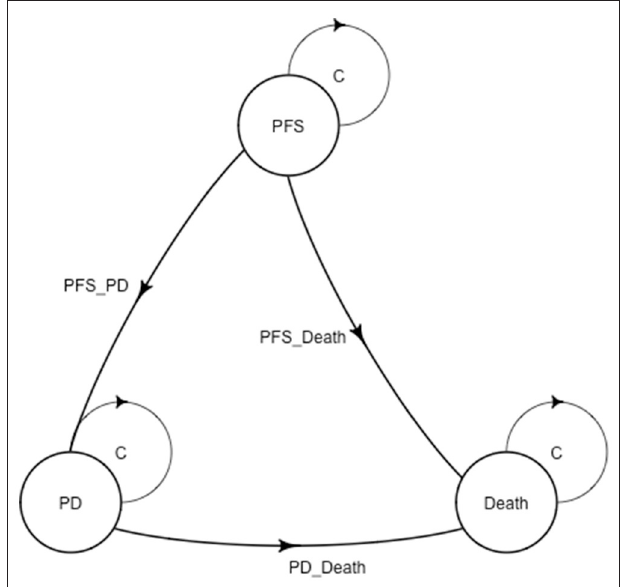
FIGURE 1 | A Markov structure was built to perform the analysis. PFS, progression-free survival; PD, progressive disease.